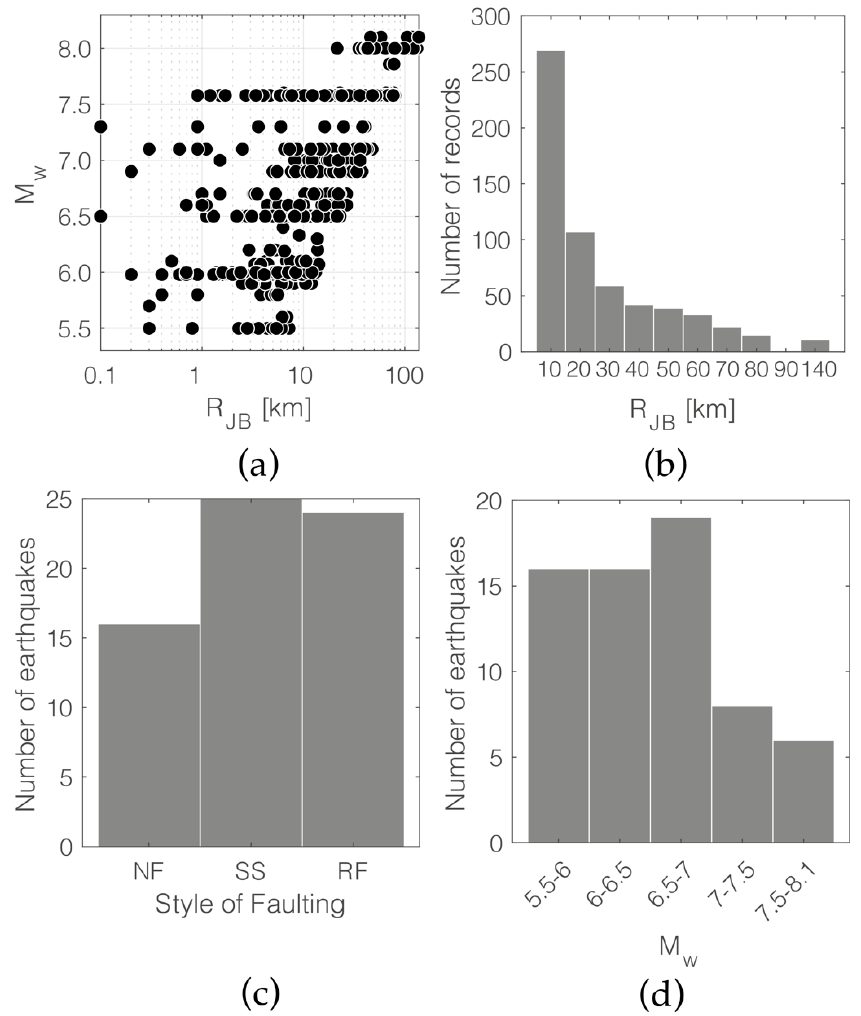
Figure 3. Data distribution of the eBASCO flat-file: ( a ) Moment magnitude vs Joyner–Boore distance (R JB ); ( b ) number of records as a function of the R JB distance; ( c ) number of earthquakes as a function of the focal mechanism; ( d ) number of earthquakes as a function of the moment magnitude.